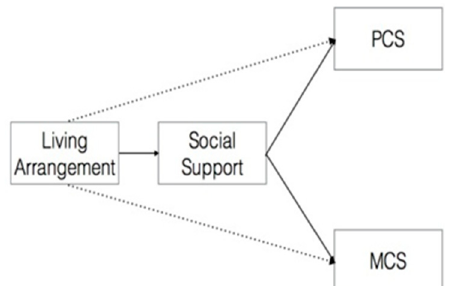
Figure 1. Mediation analysis model between living arrangement, social support, and quality of life in the school students. PCS: Physical Component Summary; MCS: Mental Component Summary. In this path for the mediator model, Living Arrangement = the independent variable, PCS/MCS = the dependent variable, Social Support = the mediating variable.